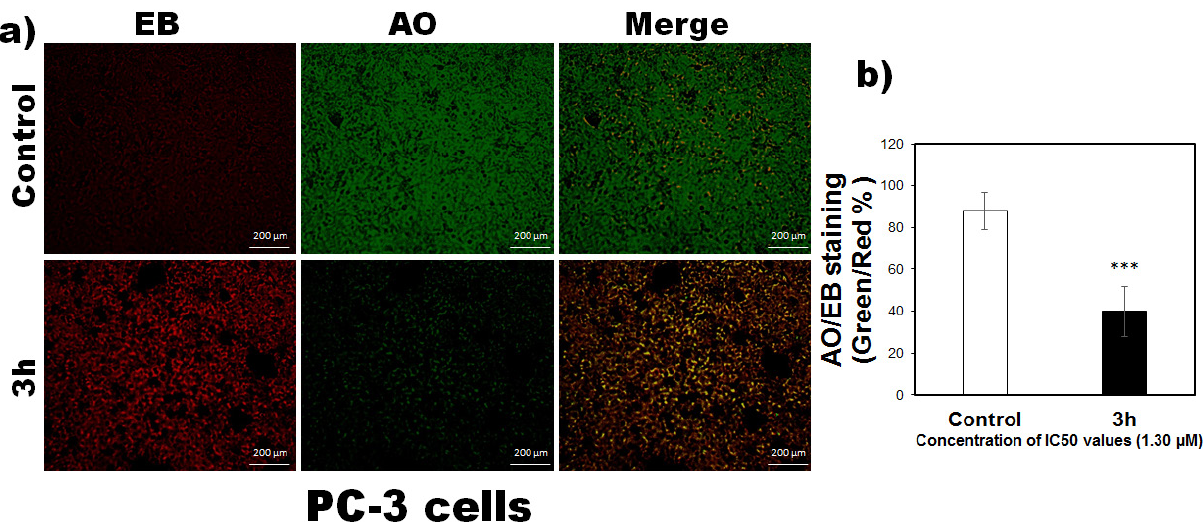
Figure 2 . PC-3 cells treated with 1.30 µM concentration of compound 3h , a) AO/EB staining in floresance imaging b) AO/EB staining ratio (*** p < 0.001 vs